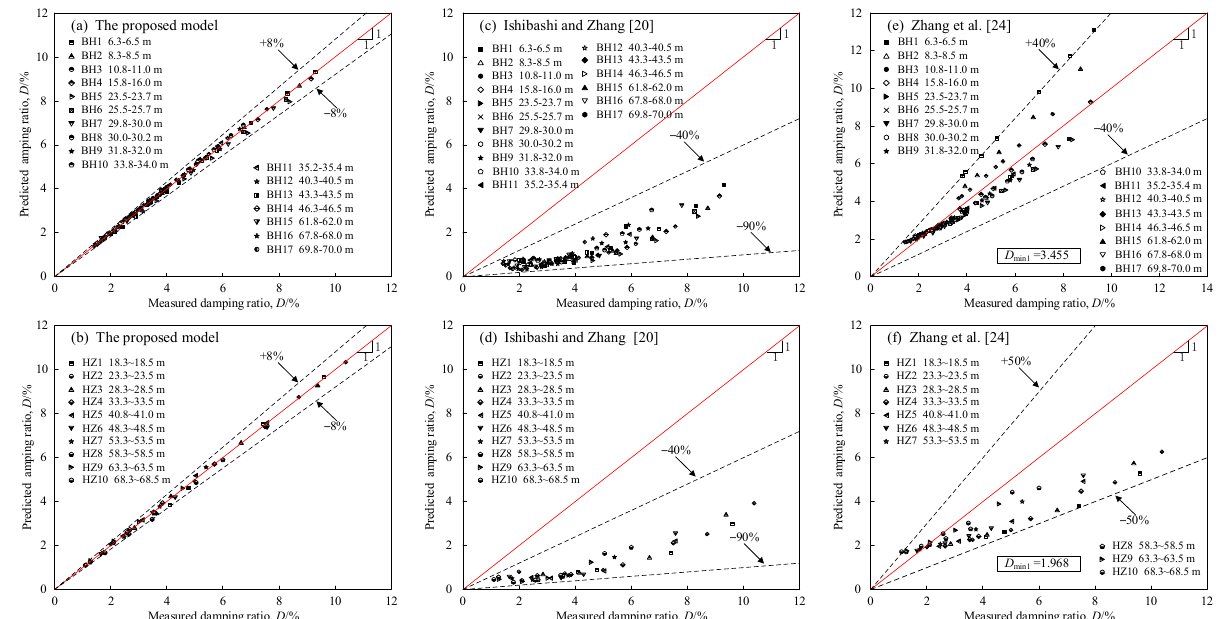
Figure 13. Comparison of the predicted performance of D values: ( a , b ) the performance of the proposed model; ( c , d ) the performance of the Ishibashi and Zhang’s [20] model; ( e , f ) the performance of the Zhang et al.’s [24] model.